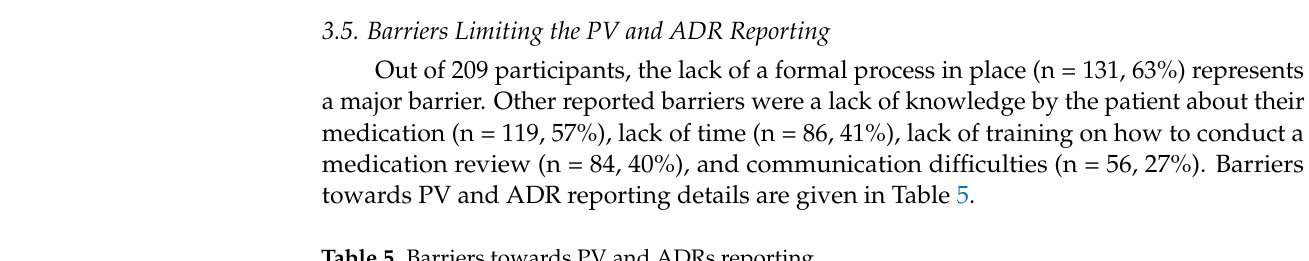
Table 5. Barriers towards PV and ADRs